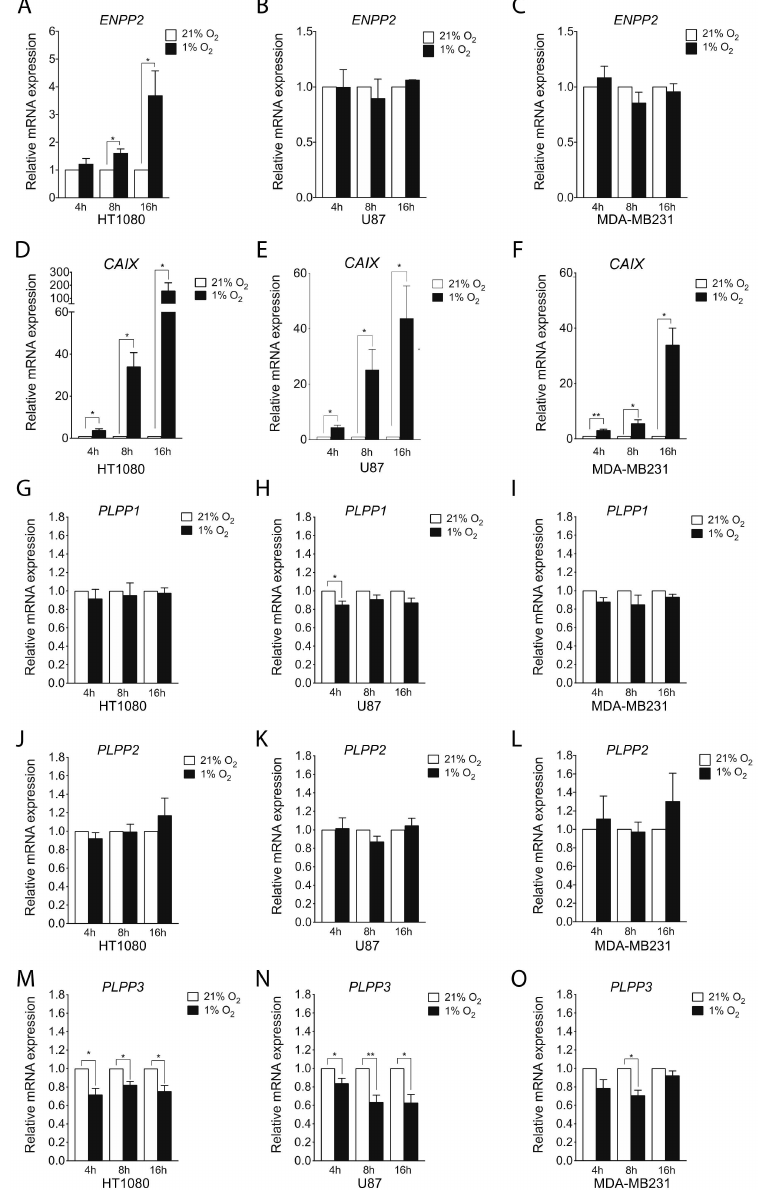
Figure 1. E ff ect of hypoxia on expression of autotaxin (ATX) and lipid phosphate phosphatases (LPP). ( A – J ) Cells were incubated under normoxic (21% O 2 ) or hypoxic (1% O 2 ) conditions for 4, 8 or 16 hours. mRNA expression of ( A – C ) ENPP2 (autotaxin), ( D – F ) CAIX (carbonic anhydrase IX), ( G–I ) PLPP1 (LPP1), ( J – L ) PLPP2 (LPP2) or ( M – O ) PLPP3 (LPP3) was evaluated by qPCR in (A, D, G, J, M) HT1080, (B, E, H, K, N) U87, or (C, F, I, L, O) MDA-MB231 cells. RPLP0 was used to normalize the data. N ≥ 3. Bars represent the mean ± SEM (* p < 0.05, ** p <